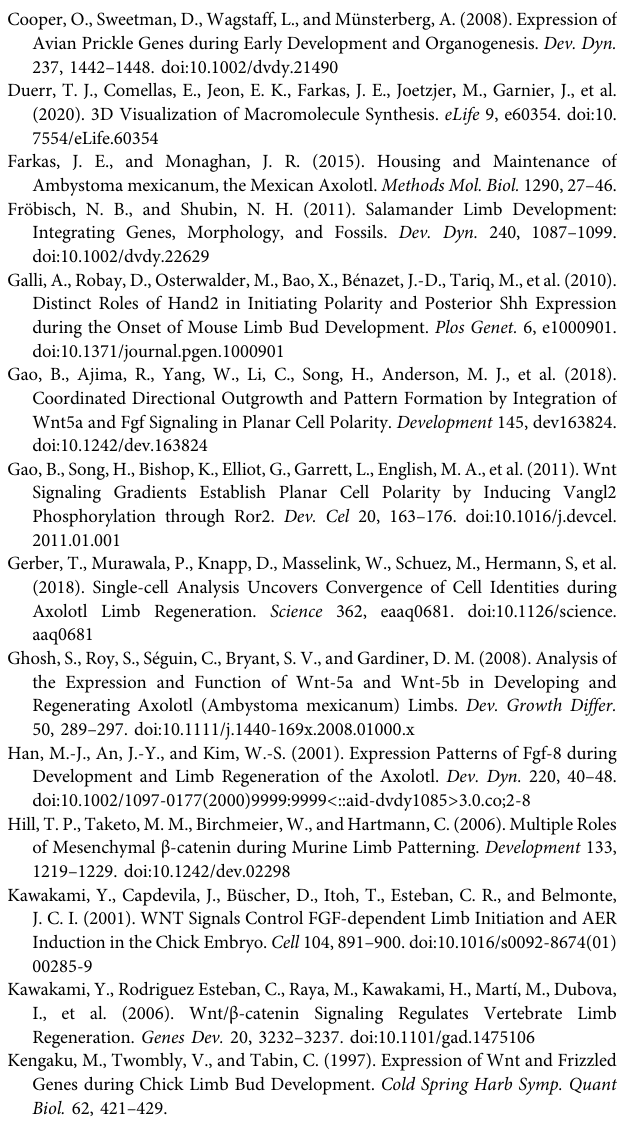
Supplementary Figure 1 | HCR-FISH on coronal sections of forelimb blastemas. (A) Early (6 dpa) blastema showing expression of Wnt3a , Wnt5a , Axin1 , Sfrp2 , Prickle1 , Ror2 , and Fzd8 . (B) Wnt ligands Wnt5a , Wnt5b , and Wnt5a in an 11 dpa blastema. Although expression was lower and auto fl uorescence was higher due to blood and the wound environment, patterns were similar to mid/late blastema stages shown in Figures 7 , 8 . Gaussian blur was performed with a radius of 2 on all images and brightness and contrast modi fi ed for presentation purposes. Supplementary Figure 2 | (A) Light-sheet imaging of a mid-bud blastema for Fgf8 (yellow), Fgf10 (magenta), and Shh (cyan). (A 9 ) An optical slice through the image shown in (A) . (B) Light-sheet imaging of a limb treated with C59 for 8 days showing a lack of expression for Fgf8 (yellow), Fgf10 (magenta), and Shh (cyan). (B 9 ) An optical slice through the image shown in (B) . Supplementary Table 1 | Probe sequences used for HCR-FISH. B1-B4 correspond to the HCR initiators used for signal ampli fi cation. Supplementary Table 2 | Genes involved in Wnt signaling that signi fi cantly changed from baseline levels at least 2